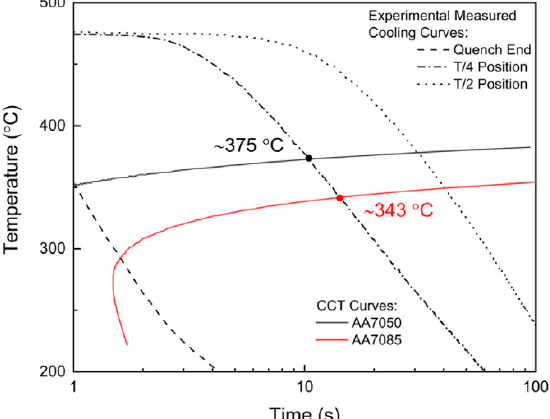
Figure 14. CCT curves for nucleation of η -phase Q-GBPs in AA7050 and AA7085. Adapted with permission from ref. [72]. 2021 Garner et al.